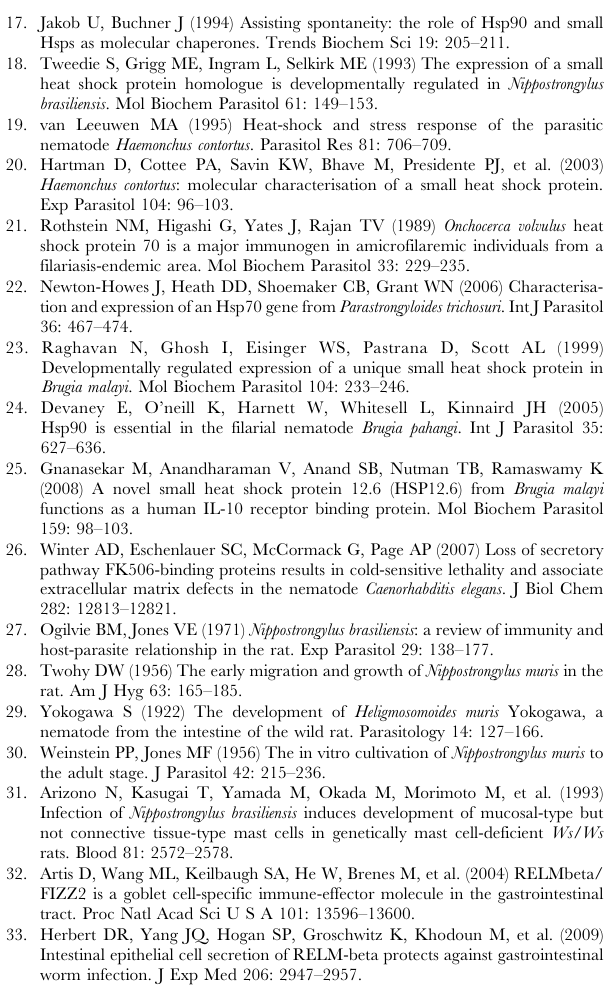
Figure S1 Anterior body of L1 (A), L2, (B), infective L3 (C), and lung-stage L3 (D) larvae of N. brasiliensis . Arrows indicate the esophageal-intestinal junction. (TIF) Figure S2 Posterior body of L1 (A), L2 (B), infective L3 (C), and lung-stage L3 (D) larvae of N. brasiliensis. Arrowheads, anus; arrows, small protuberance. (TIF) Figure S3 L4 larvae (A–C) and adult worms (D, E) of N. brasiliensis . L4 larvae were those at 3 days PI and adult worms were those at 6 days PI. A, anterior body, showing the cephalic cuticular expansion (ce). B, posterior end of a female worm, showing the primitive vulva (pv) and anus (a). C, posterior end of a male worm, showing the primitive copulatory bursa (pcb). D. middle of a female body, showing intrauterine eggs. E, posterior end of a male worm, showing copulatory spicules (s) and copulatory bursa (cb). (TIF) Figure S4 3D structure of Hsp12.6 and FKB-3. (TIF)